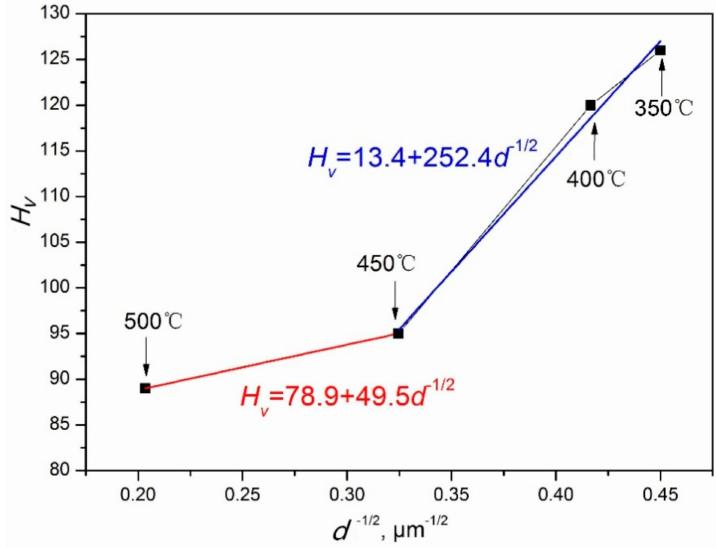
Figure 16. The relationship between d − 1 / 2 and H v